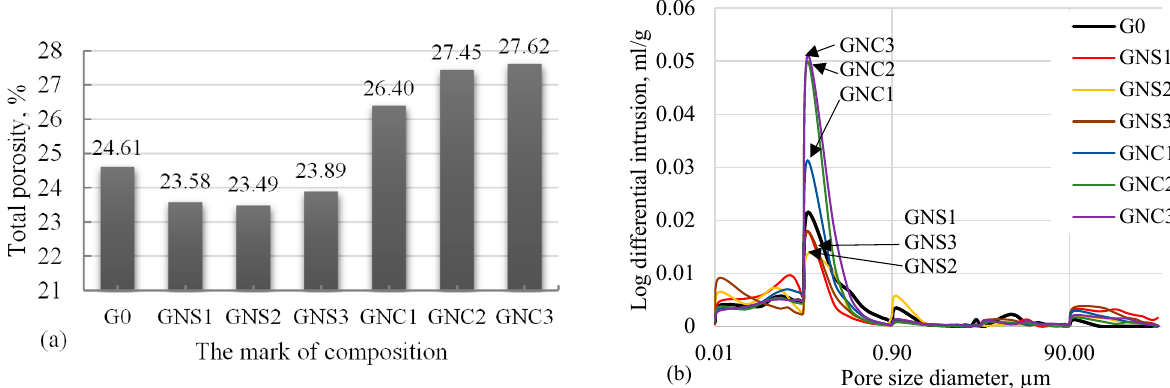
Figure 15. Results of total porosity ( a ) and pore size distribution ( b ) of CAC pastes. From the results given in Figure 15a, it is clear that the total porosity of the paste with However, the increased porosity of NC modified samples may be favourable in some cases for using this cement in refractory castable exposed to high temperatures. In such a case, greater porosity of the cement paste may be advantageous because the drying is were exposed to the temperature of 105 ± 5 ◦ C, so it can be expected that their structure the density of C 3 AH 6 is higher than that of CAH 10 or C 2 AH 8 [47]. The measurements of samples follows a polymodal profile; the largest number of pores are ~0.1 µ m in size. There are clear differences between the porosity of the samples with NS and NC. The pore volume (~0.1 µ m size pores) was the lowest in the samples containing NS, whereas NC increase the pore volume by 3 times (Figure 15b). Little change in the pore volume of other pore